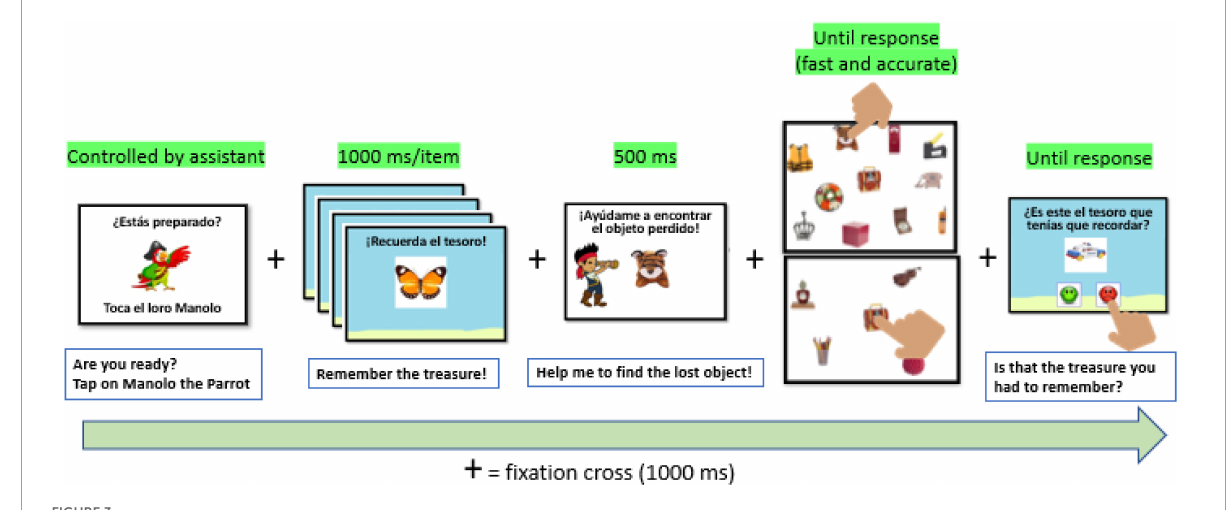
FIGURE3 Example of a dual-task trial. In the original version, the size ratio of the images is stated in the method. The instructions were written in Spanish, the language spoken by the participants; the translation in English is included below each